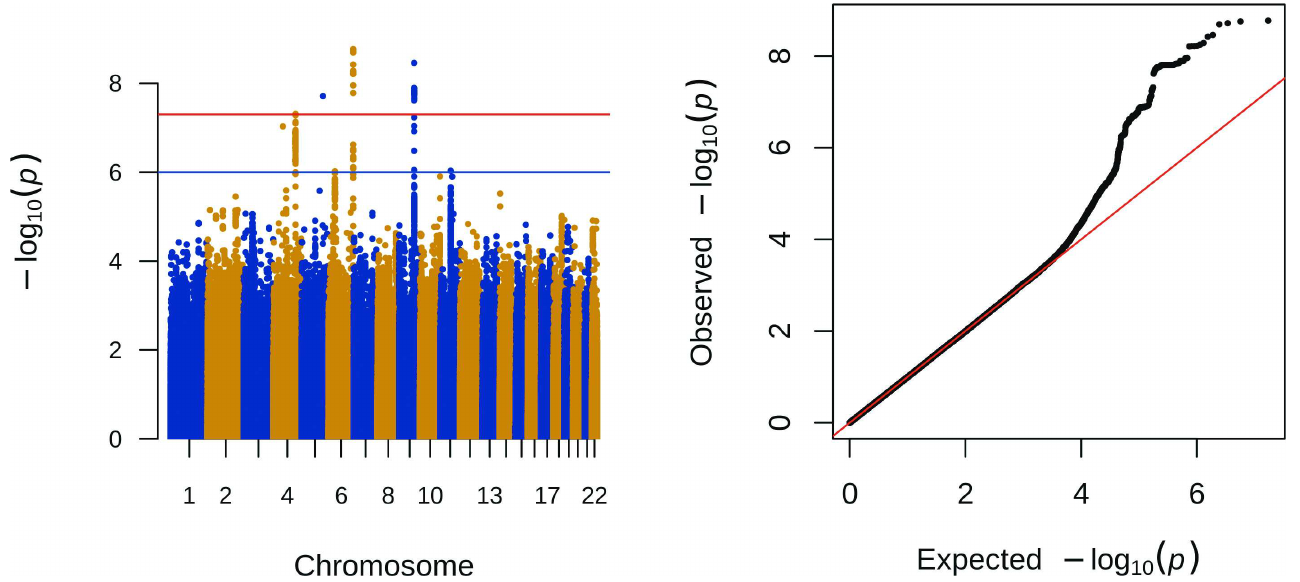
Fig 1. Association of genome-wide variants with plasma TSH concentrations. SNPs are plotted on the x-axis accordingto their chromosomal positionagainst the–log10( p -value). The results were considered genome-wide significantwith a p < 5 (cid:1) 10 − 8 . A thresholdfor replicationwas set at p < 1 (cid:1) 10 − 6